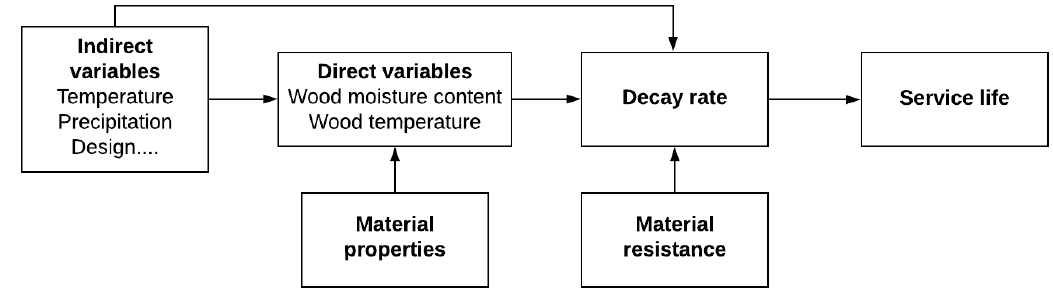
Figure 1. The framework illustrates the process steps required to model the service life of a wooden